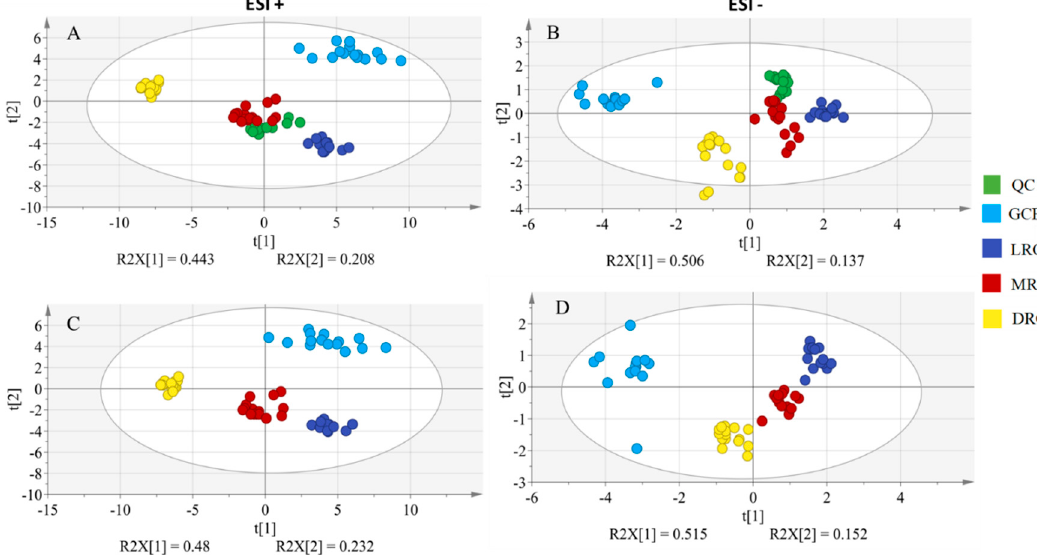
Figure 1. Principal component analysis (PCA) score plots obtained in positive and negative ionization modes for the four studied coffee groups (GCB, LRC, MRC, and DRC) submitted to different roasting degree with QC samples ( A , B ) and without QC samples ( C , D ).